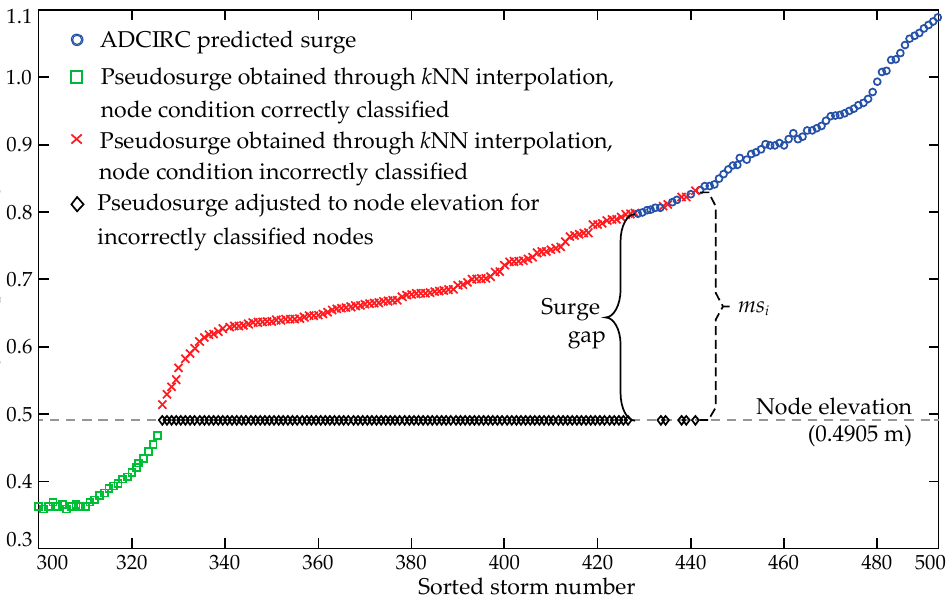
Figure 6. Ordered surge and pseudo-surge values for a specific node, with the node elevation also shown as a dashed grey line. Note that a portion of the total storm database is shown, corresponding to pseudo-surge values close to the node elevation. The correctly and incorrectly classified instances are distinguished for the pseudo-surge estimates. Note the jump created if an adjustment for the pseudo-surge is utilized in order to establish a correct classification. The maximum surge misinformation is also highlighted in the plot.